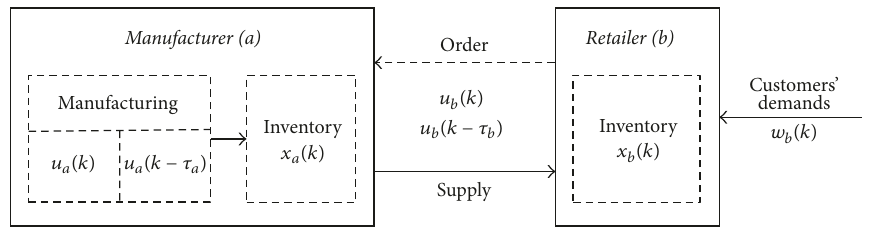
Figure 1: Basic dynamic model of two-stage SC